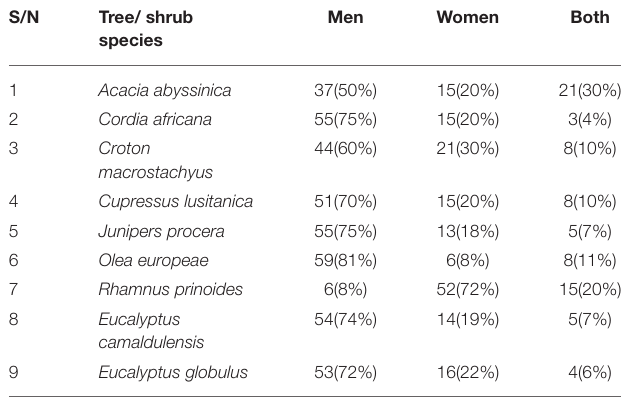
TABLE 8 | Tree management decision.